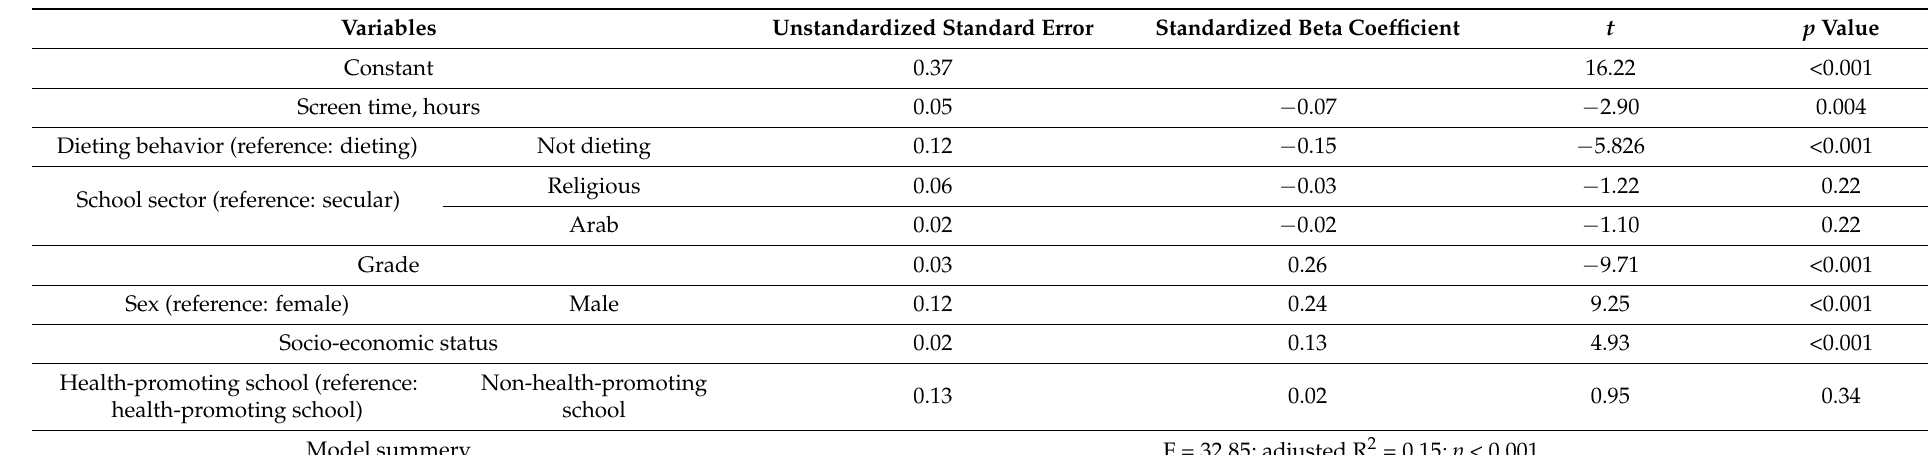
Table 4. Summary of multiple regression analysis: physical activity